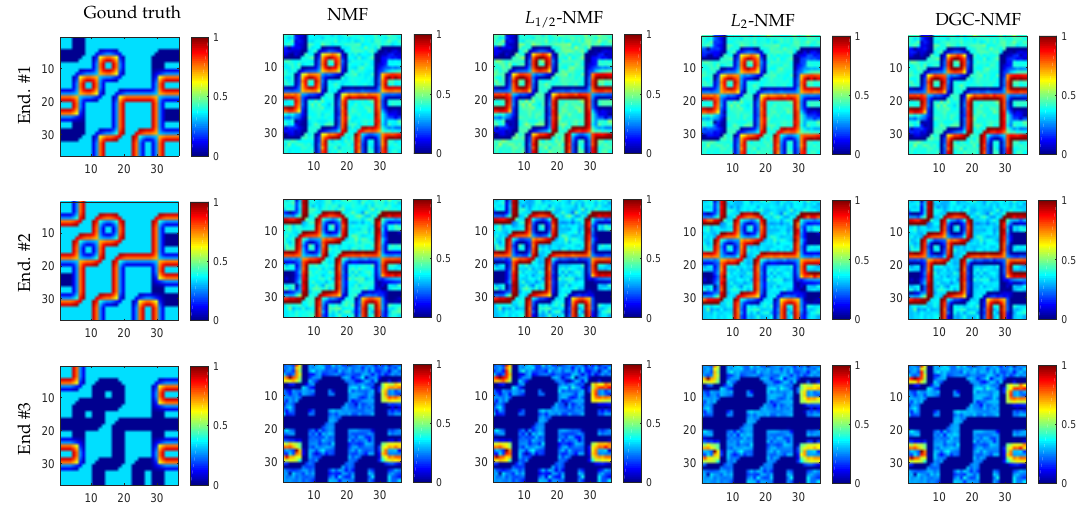
Figure 6. Abundance maps of synthetic data estimated by NMF, L 1/2 -NMF, L 2 -NMF, and DGC-NMF, respectively. Each row shows the corresponding abundance maps of a same endmember by different algorithms.